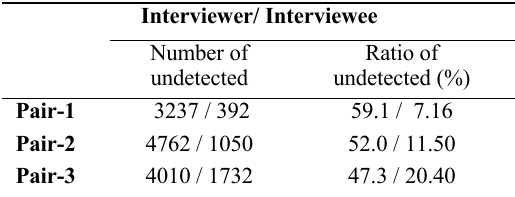
Table 5. The number and ratio of image-frames that raw gaze data were